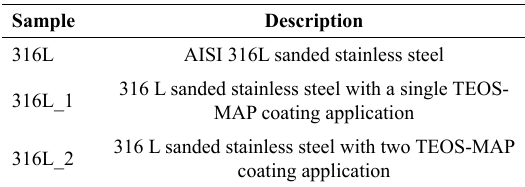
Table 1. Description of studied